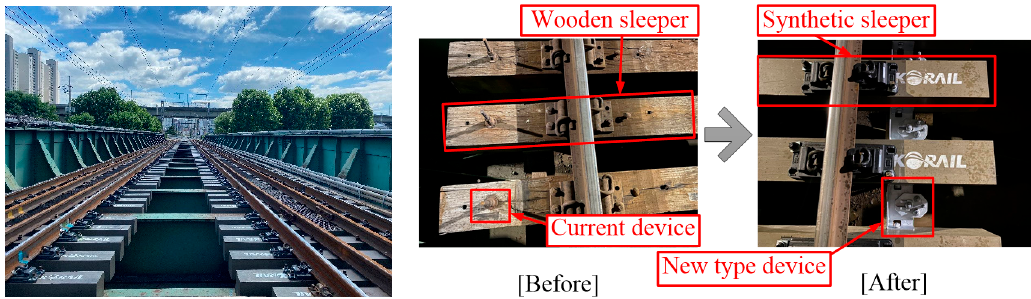
Figure 2. Application example of new girder–sleeper fastener device for a CWR track on an open-deck steel plate girder bridge in Korea.